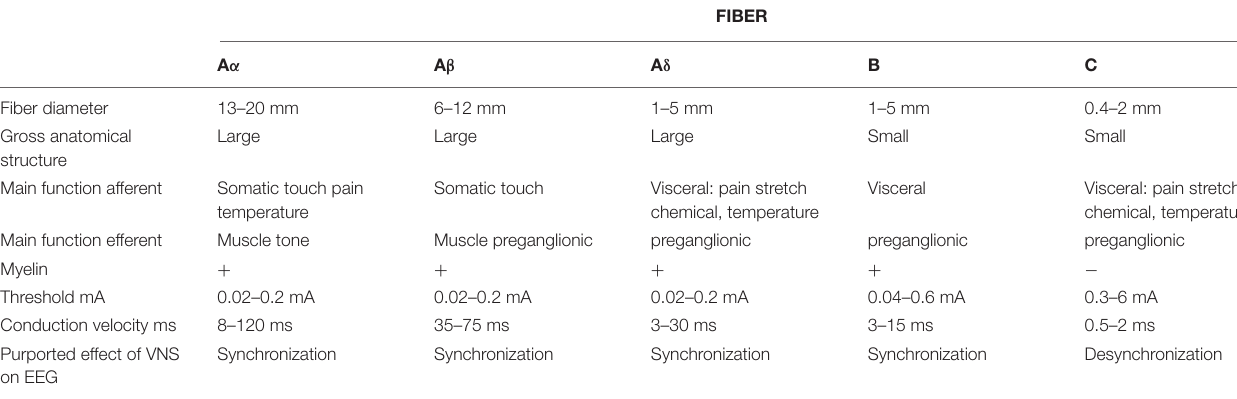
TABLE 1 | The constituent fibers of the vagus